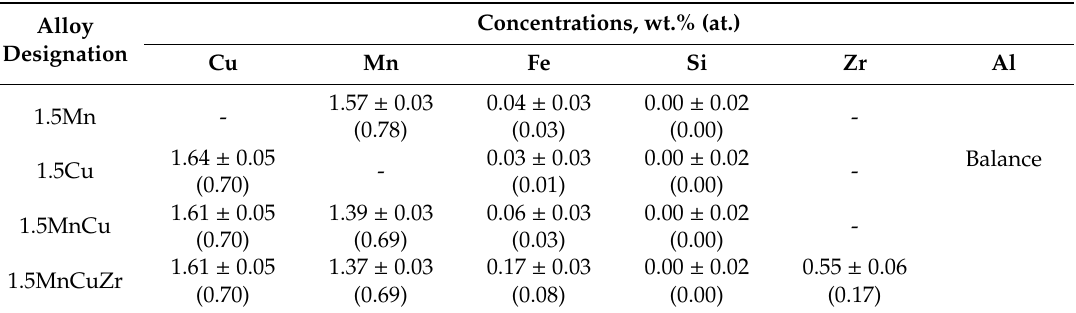
Table 1. Chemical compositions of experimental